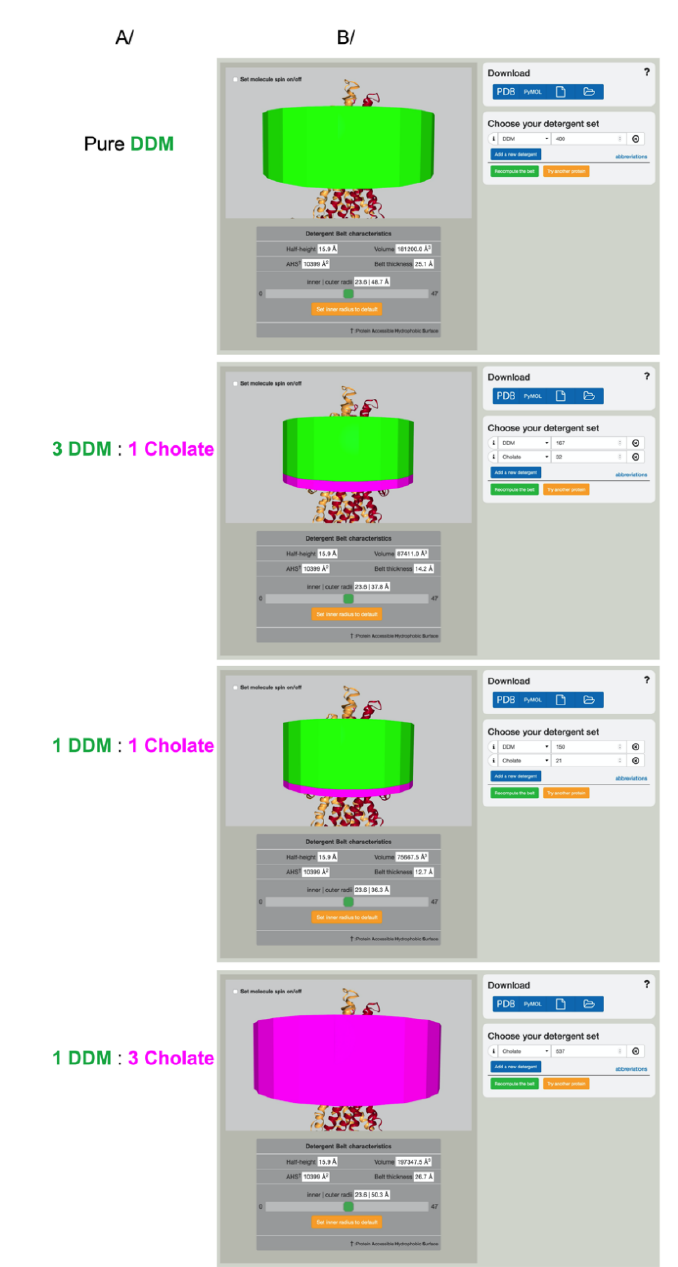
Figure 3. Representation of detergent mixtures. ( A ) Purification condition for the ABC transporter BmrA as described in [36]. The ratios define the detergent’s molar ratio used during the purifica- tion. ( B ) The measured number of detergents is depicted using Det.Belt. Note that the measured amounts differ completely from the detergent ratio in purification buffers [36]. PDB code used in this figure: